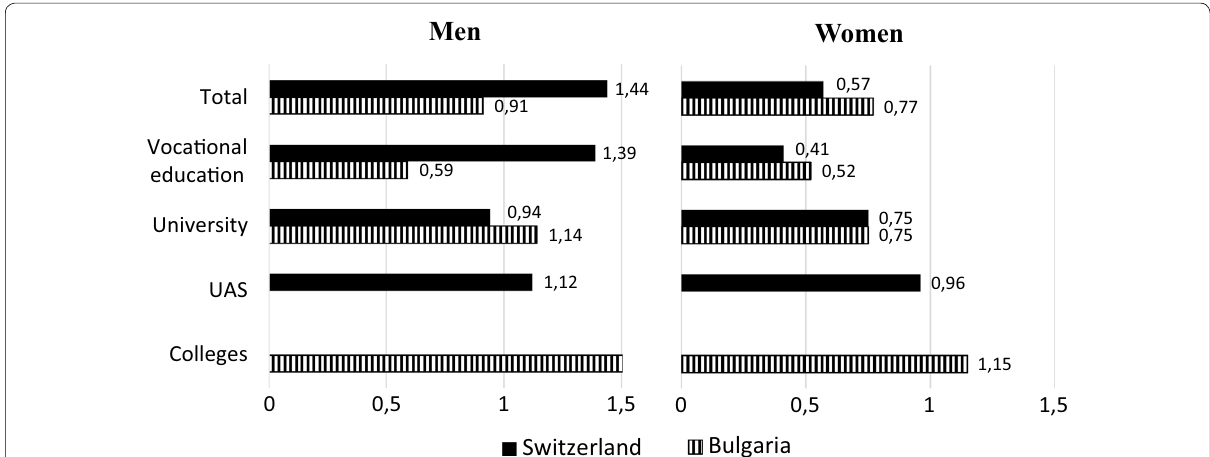
Fig. 2 Linkage strengths by educational sector and gender (Mutual Information Index) (Source: Own calculations)